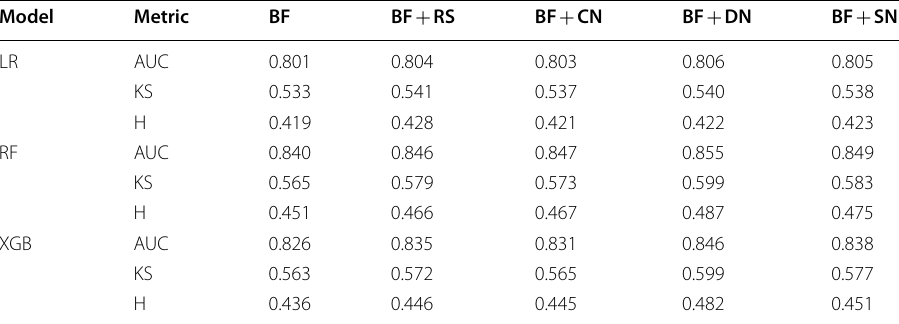
Each metric is measured by the mean of 100 estimates obtained by repeating the outer ten-fold cross-validation procedure ten times